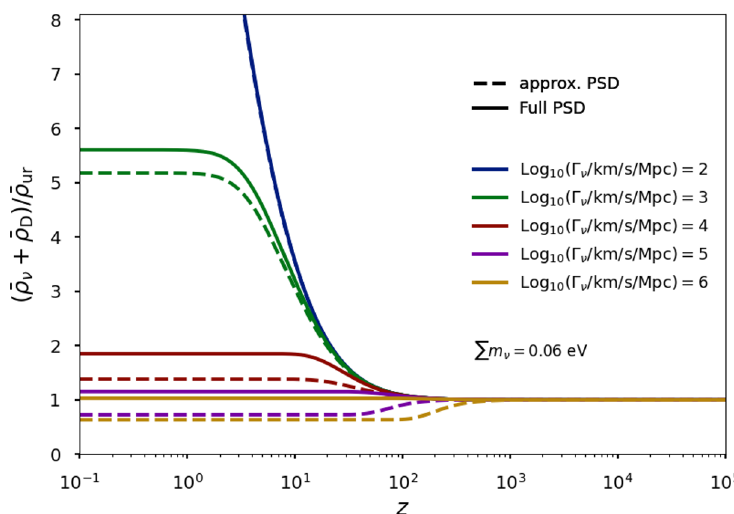
Figure 3 . Redshift evolution of the quantity (¯ ρ ν + ¯ ρ D ) / ¯ ρ ur (where ¯ ρ ur denotes the energy density of stable massless neutrinos), which should be equal to 1 in the limit of relativistic decays. We consider a very small value of the neutrino mass sum, P m = 0 . 06 eV , and several values for the decay ν width, Log (Γ km / s / Mpc) . “approx. PSD” refers to the approximated phase space ν / 10